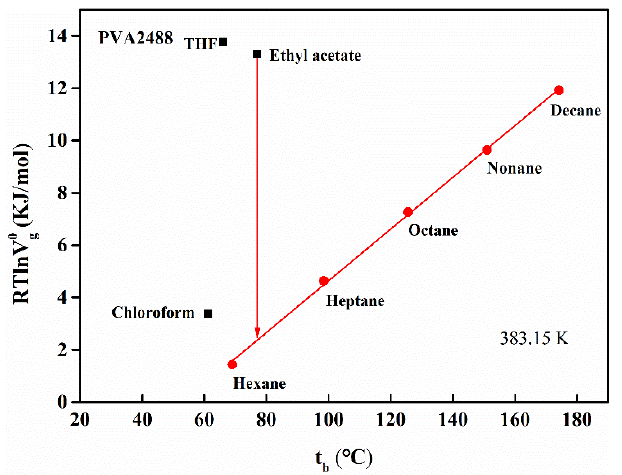
Figure 7. The relationship between RT lnV (cid:2917)(cid:2868) and the boiling point t (cid:2912) of the probe solvent (at 383.15 K, take PVA2488 as an example). take PVA2488 as an